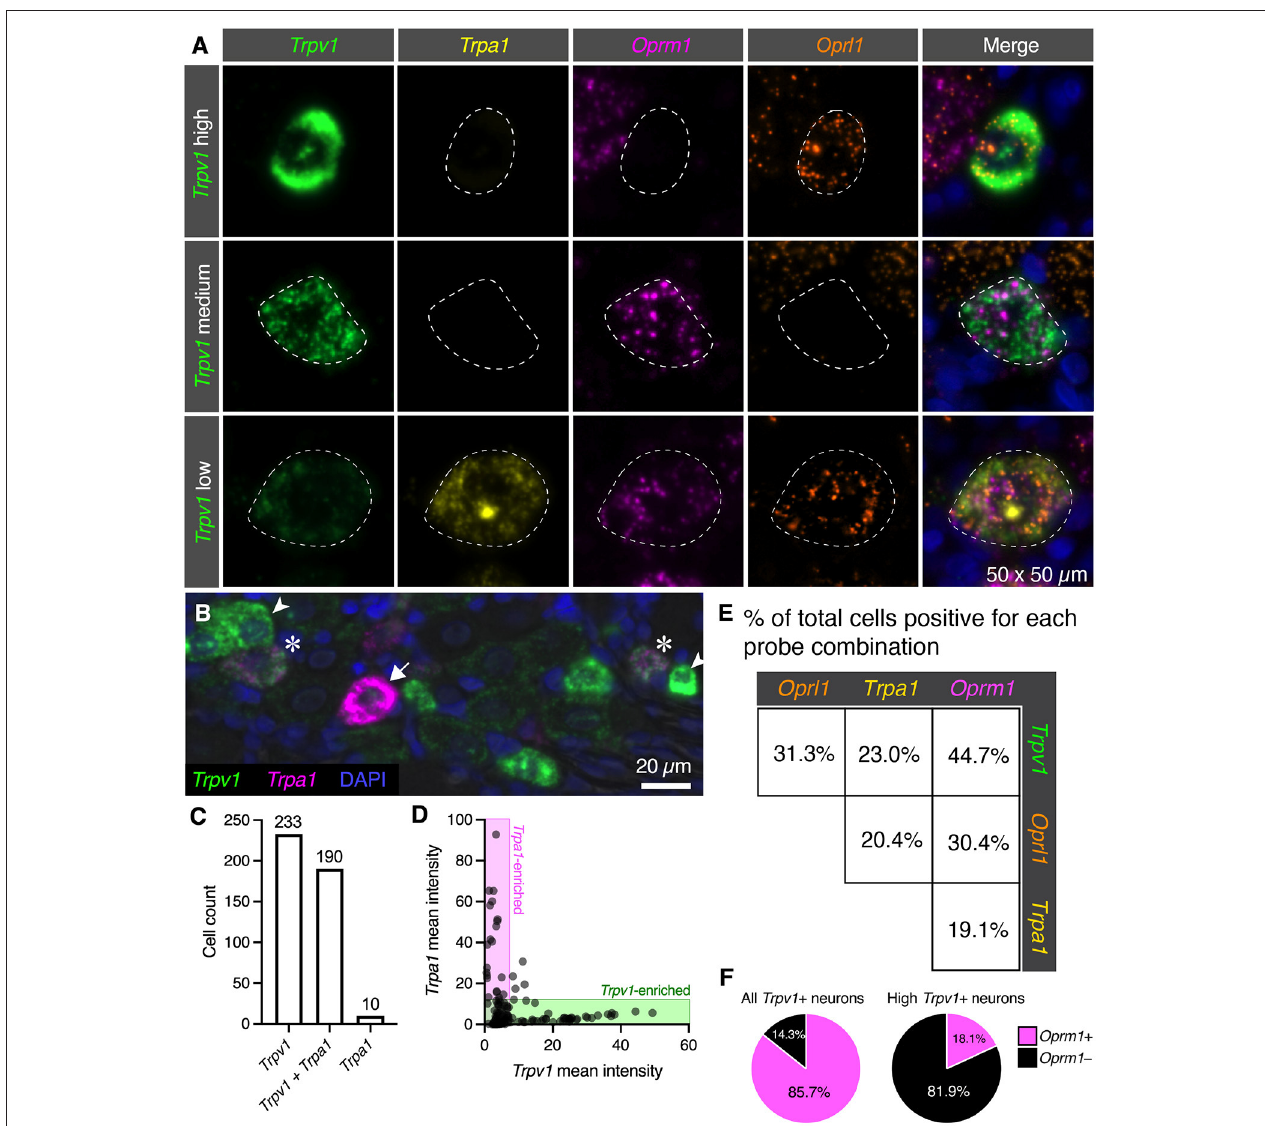
FIGURE 5 | Quantification of nociceptive ion channel and opioid receptors. We further examined the subpopulations of DRG neurons shown in Figure 3 . (A) Enlarged and enhanced fields were shown for each of three representative cell populations corresponding to high, medium and low Trpv1 expression. Note that several populations of cells have medium Trpv1 expression, but that one of the most common subtypes ( Trpv1 and Oprm1 alone), was selected. Similarly, a quad-positive neuron was selected as representative of low Trpv1 expression. (B) To examine the relationship between Trpv1 and Trpa1 in particular, expression levels in perikarya of cells expressing either marker were examined in further detail. In this representative field, neurons strongly enriched for Trpv1 (arrowheads) or Trpa1 (arrow) are indicated, as well as two neurons (asterisks) that co-express these two ion channel genes. (C) Using cell counting, we identified the coincidence of these two markers. More cells express Trpv1 than Trpa1 with the majority of Trpa1 cells co-expressing Trpv1 , and only 10 Trpa1 cells expressing no detectable Trpv1 . (D) However, + + cells expressing high levels of either Trpv1 or Trpa1 express very low levels of the other transcript. Therefore, the expression of these two markers while coincident, appears to be anticorrelated (note that points fall on the axes rather than in the middle of the plot. (E) Pairwise coincidence is shown for each of the four labels in this experiment. All of these combinations are common (with the rarest being approximately 19.1% of all cells). High Trpv1 neurons, in particular, seemed to differ from other Trpv1 neurons in terms of Oprm1 expression. (F) We addressed this by counting high Trpv1 neurons separately from other Trpv1 neurons (shown in pie charts). Whereas average Trpv1 neurons expressed Oprm1 the majority of the time (85.7%), the high Trpv1 neurons expressed Oprm1 only 18.1% of the time. On average, the expression in these cells was also lower ( Supplementary Figure 3 ). Outlines (dotted lines) of neuronal perikarya are shown to enhance visbility.